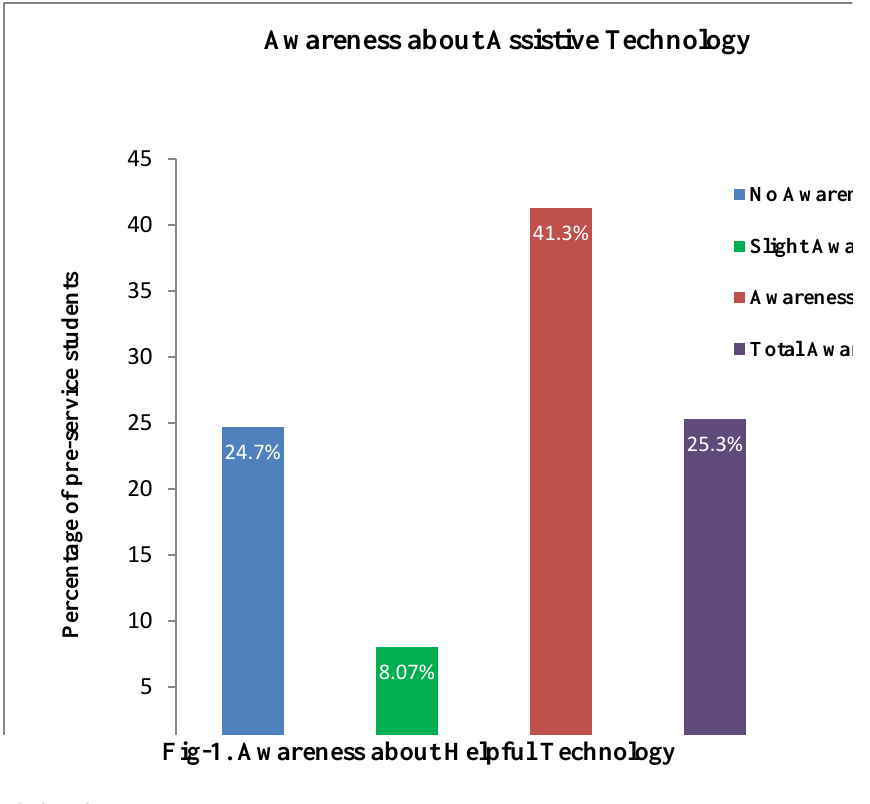
Table 3: Showing the attitude of pre-service students towards